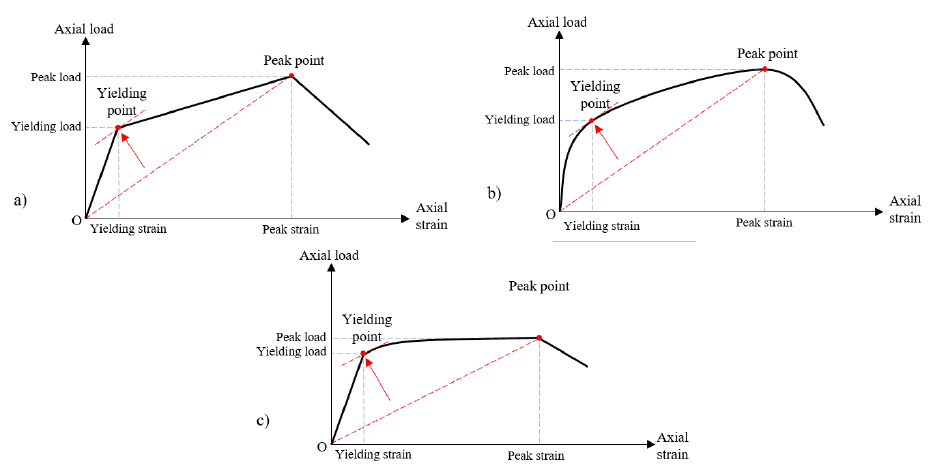
Figure 6. Farthest Point Method to determine yield point: ( a ) bilinear curve; ( b ) without obvious turning curve; ( c ) traditional elastic–plastic